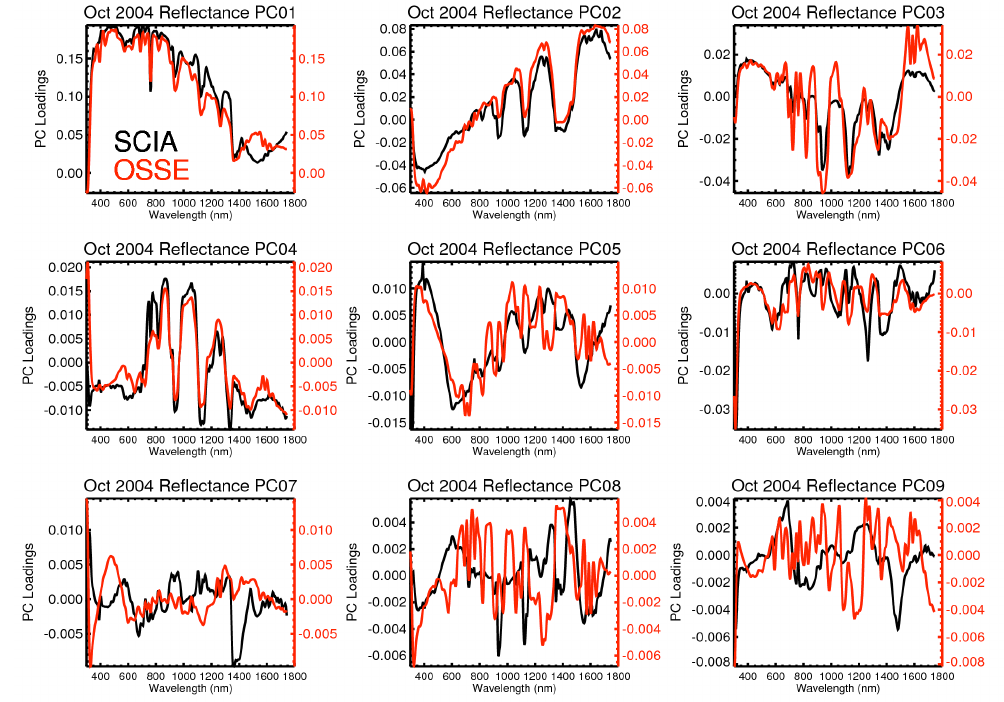
Fig. 4. The first nine October 2004 SCIAMACHY (black) and OSSE (red) principal components show a close comparison between the two data sets. Physical variables are identifiable within some PC spectral shapes including clouds (PC1), vegetation (PC4), and water absorption